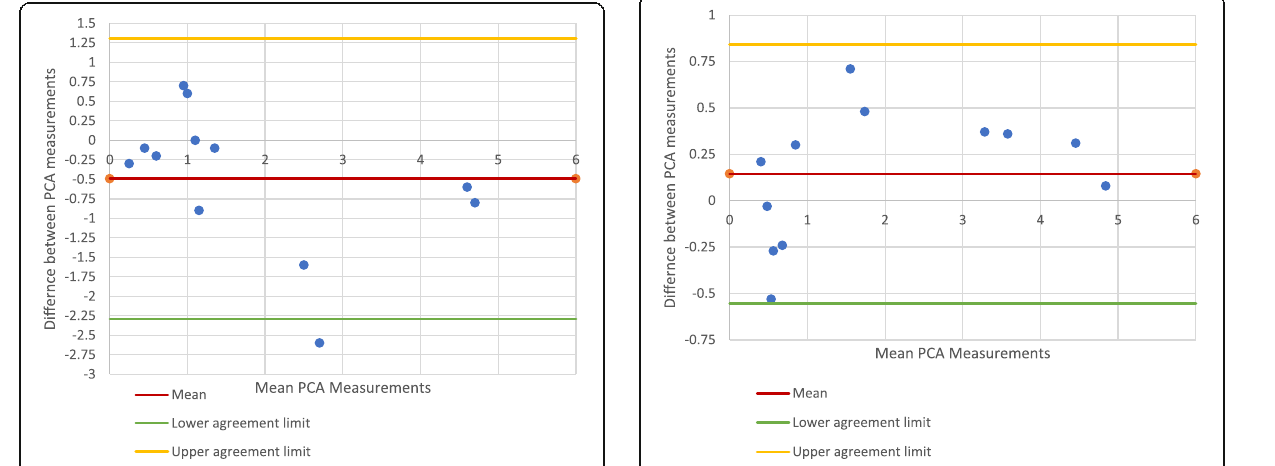
Fig. 6 PCA Measurements on anatomical axis-photography vs . CT